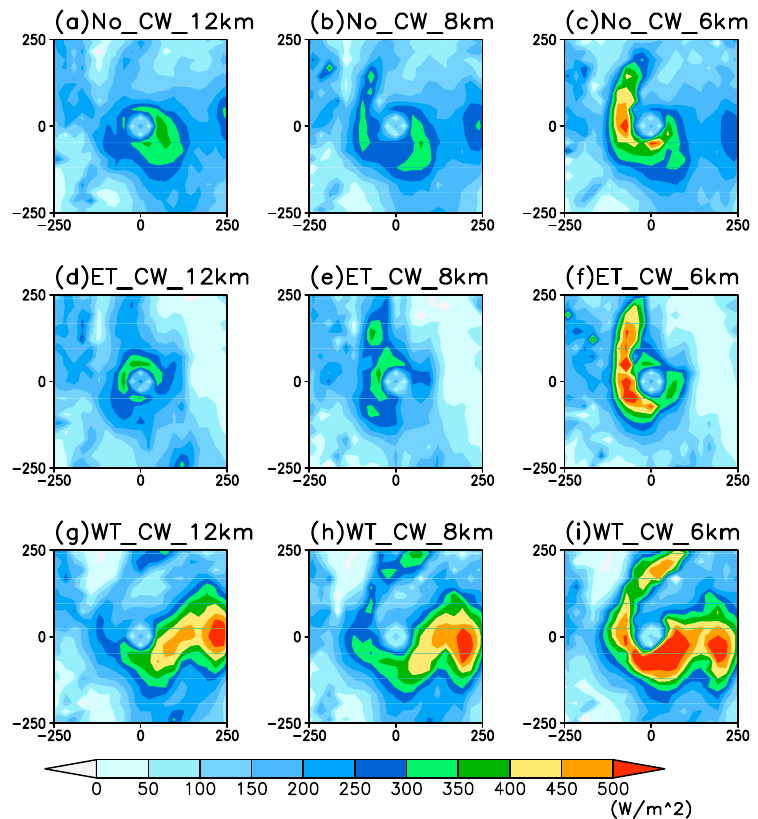
Figure 10. The 12-h averaged latent heat flux in the inner region of TC (250 km × 250 km) over periods (48~60 h) in ( a ) No_CW_12 km, ( b ) No_CW_8 km, ( c ) No_CW_6 km, ( d ) ET_CW_12 km, ( e ) ET_CW_8 km, ( f ) ET_CW_6 km, ( g ) WT_CW_12 km, ( h ) WT_CW_8 km and ( i ) WT_CW_6 km experiment of Typhoon Tembin.